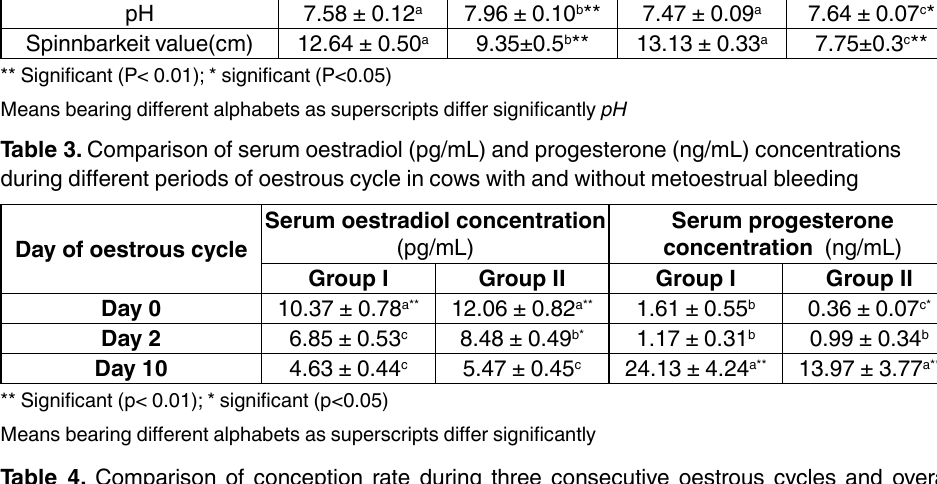
table 4. Comparison of conception rate during three consecutive oestrous cycles and overall conception rate in cows with and without metoestrual bleeding